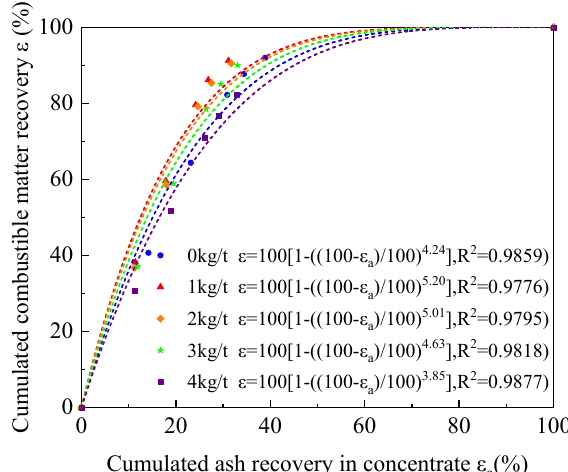
Figure 2. The Fuerstenau upgrading curve of difficult-to-separate and high-ash coal flotation under the action of SPP.